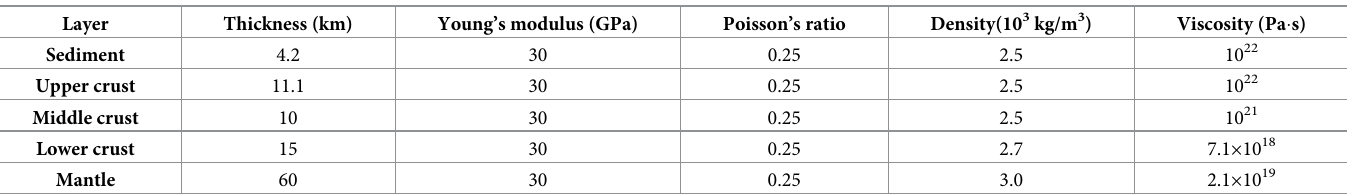
Table 2. Parameters of rock properties in the